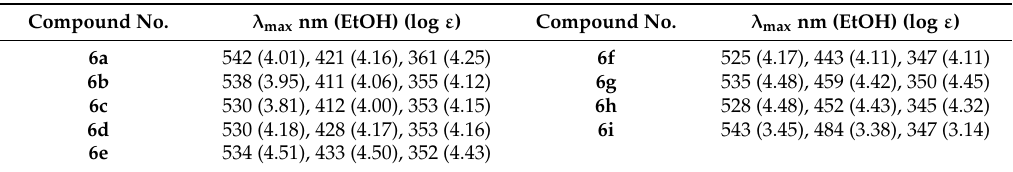
Table 1. UV Spectra of 4-(5-arylazo-2-hydroxystyryl)-1-methylpyridinium iodide 6a – i in ethanol. Compound